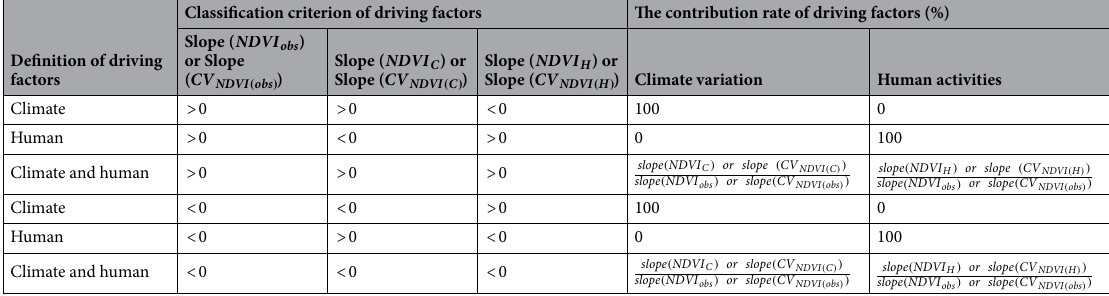
Table 2. Classification criterion and contribution rate of driving factors of NDVI or CV NDVI